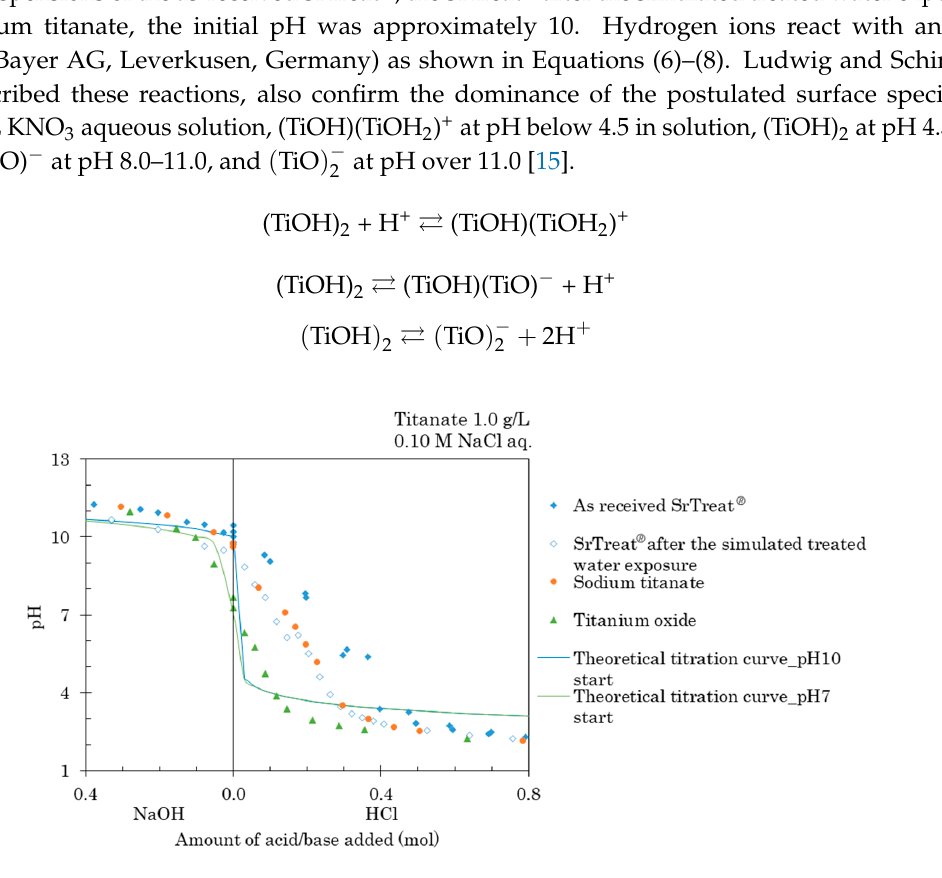
Figure 7. Titration curves of the titanates in the present study in 0.10 mol/L NaCl solution.